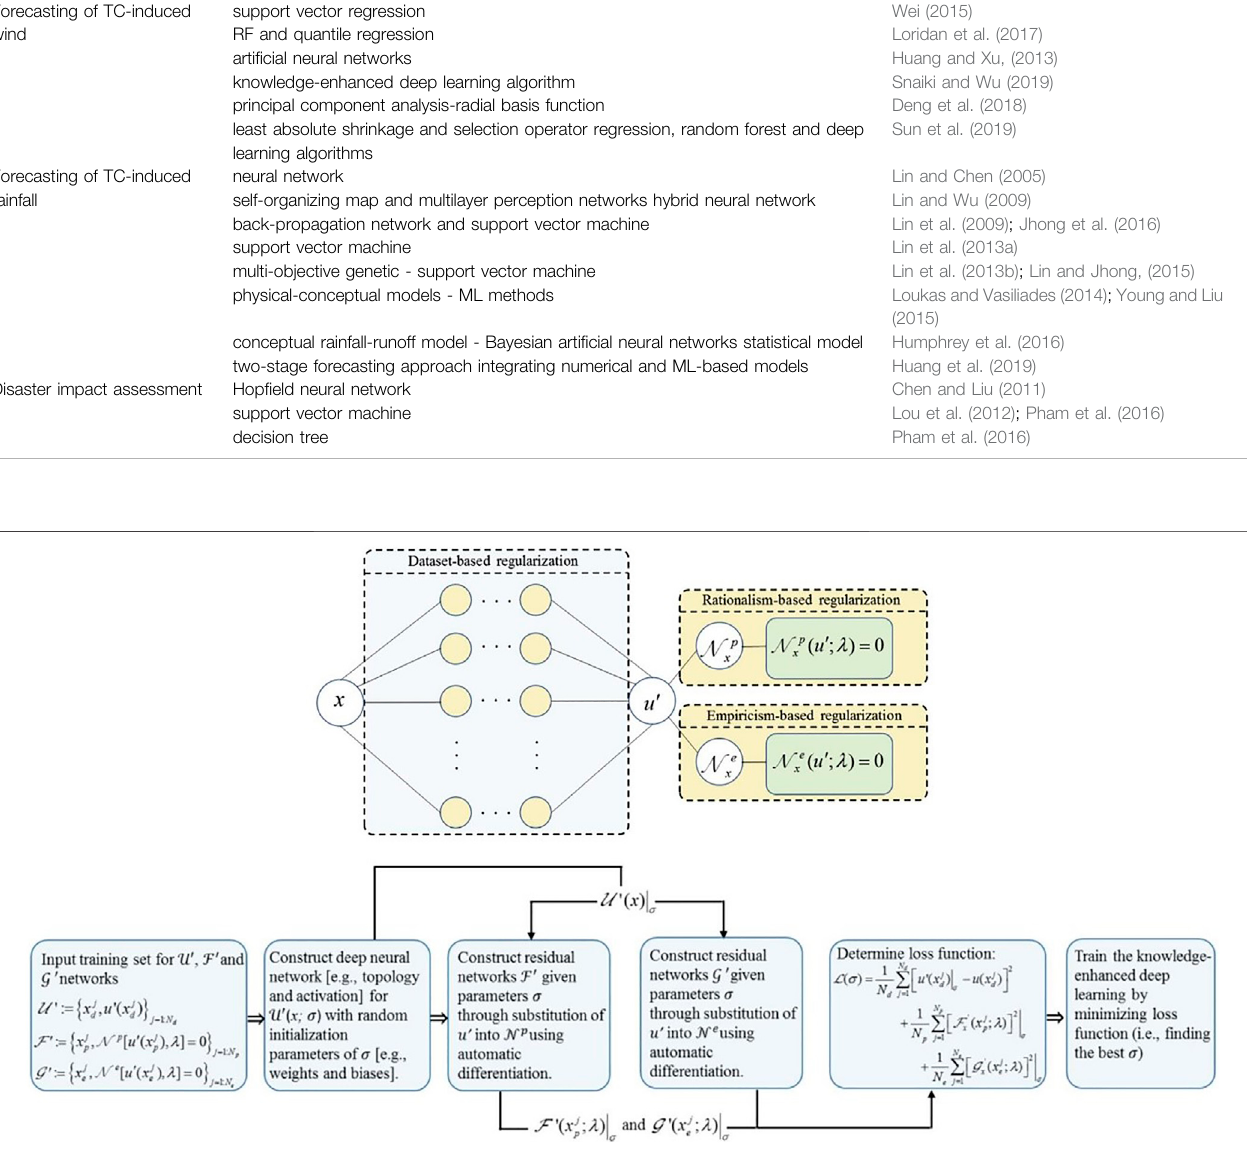
Frontiers in Earth Science |